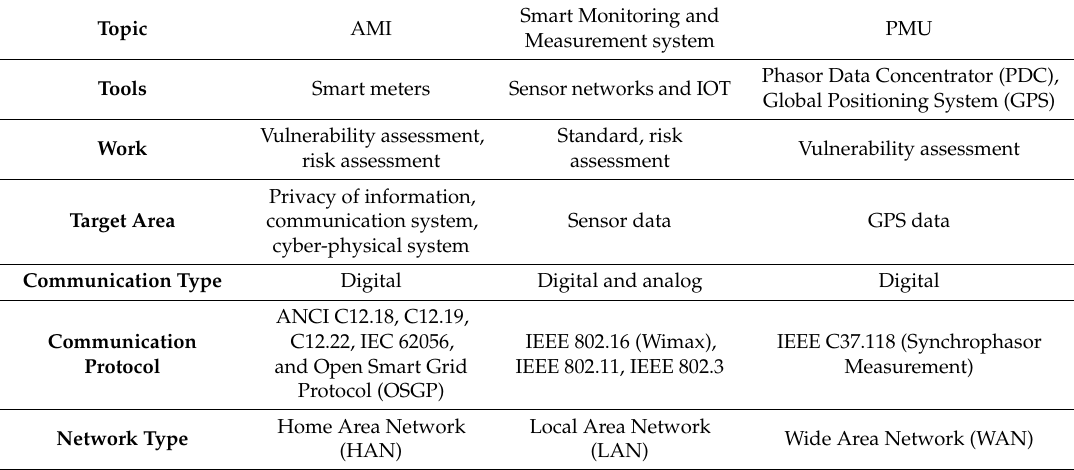
Figure 3. Operational block diagram of Phasor Measurement Unit (PMU). This device is used to measure and monitor synchronized system parameters from different locations within the power network based on a common reference time [40]. A comparison among AMI, smart monitoring system, and PMU is tabulated in Table 2. Table 2. Comparison among AMI, smart monitoring system, and PMU [41,42].